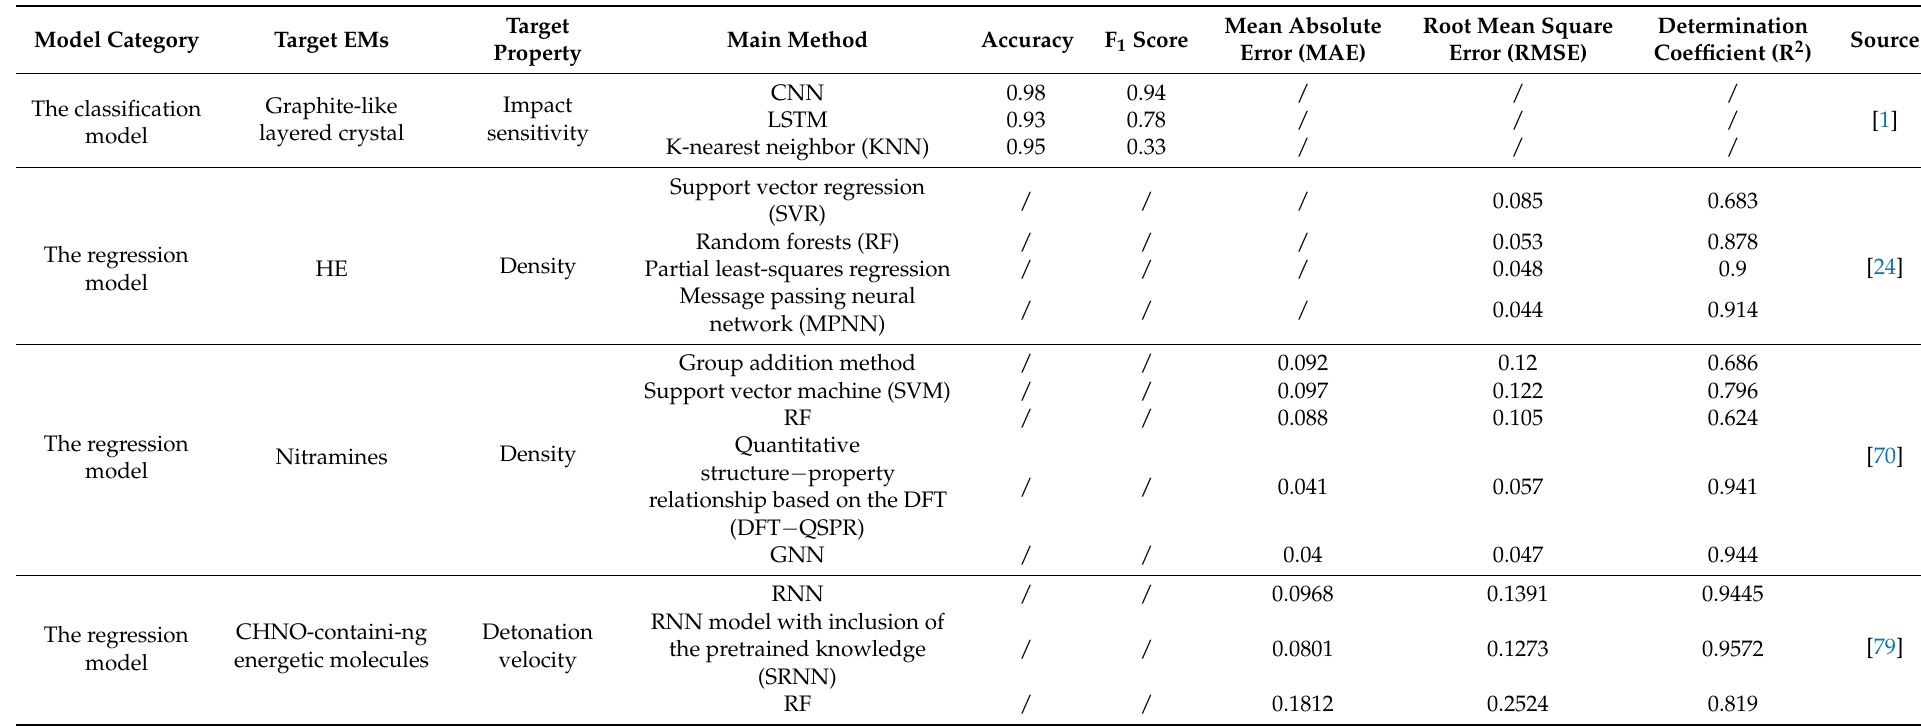
Table 2. A comparison of the prediction performance by the computer-learned representation and the traditional class feature